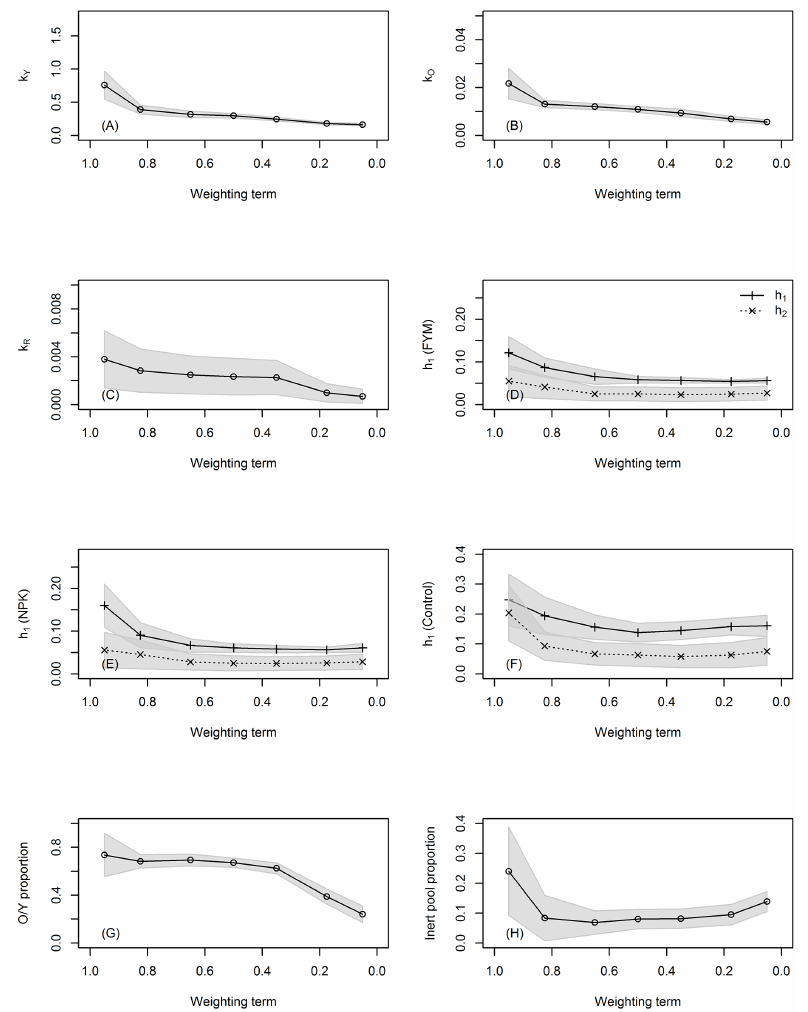
Figure 6. Effect of the SO 14 C data over the main SOC parameters in structure III. In this scale 1 means only total C, 0 means only SO 14 C. The shaded areas represent the error of the calibrated parameter (calculated as standard deviation of the whole Markov